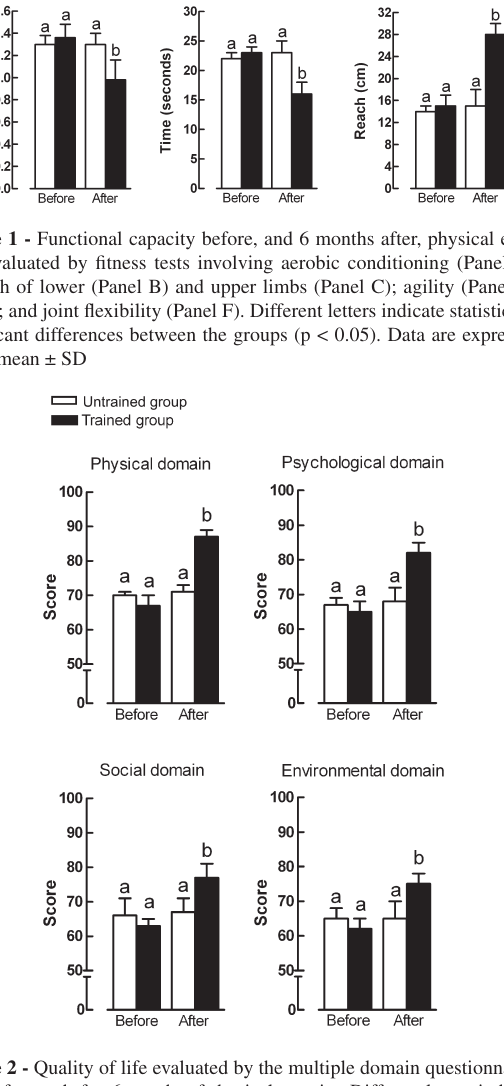
Figure 2 - Quality of life evaluated by the multiple domain questionnaires both before and after 6 months of physical exercise. Different letters indicate statistically significant differences between the groups (p < 0.001). Data are expressed as the mean ±